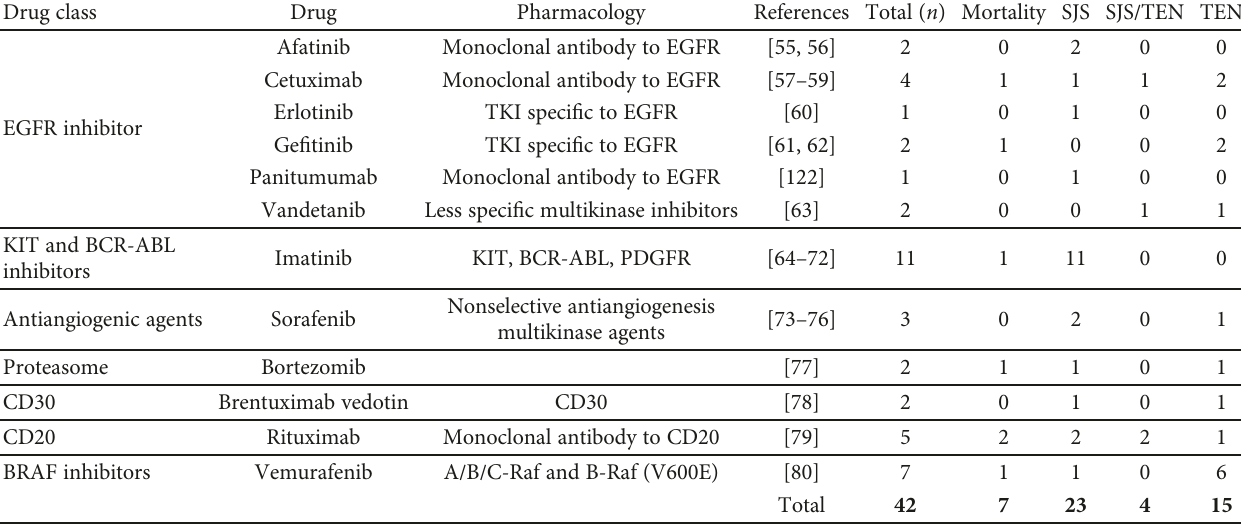
Table 2: Anticancer targeted therapy-related severe cutaneous adverse drug reactions from the English literature (year: 1950 – 2017).